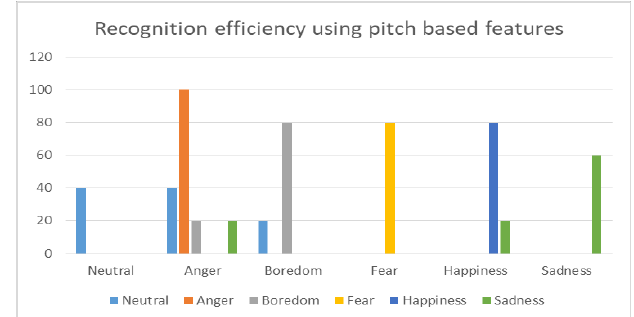
Fig. 8 Recognition efficiency using pitch based features